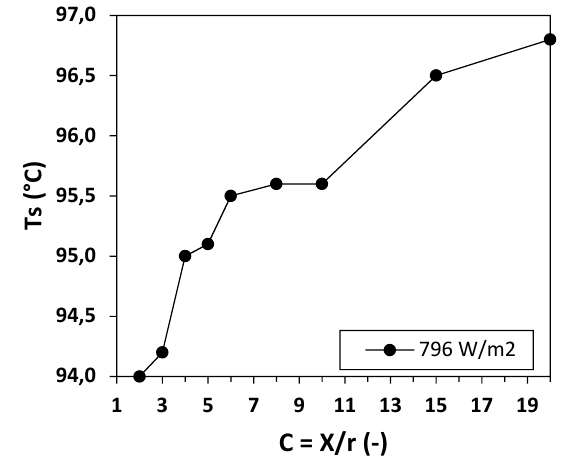
Fig. 8 . Surface temperature for q = 796 W/m 2